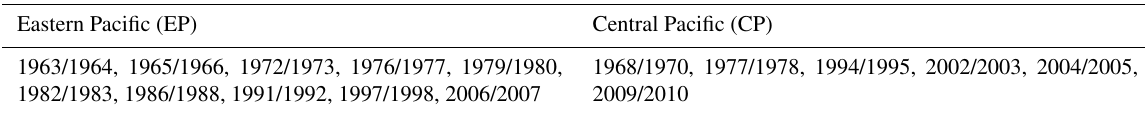
Table 1. The classification of El Niño events. Eastern Pacific